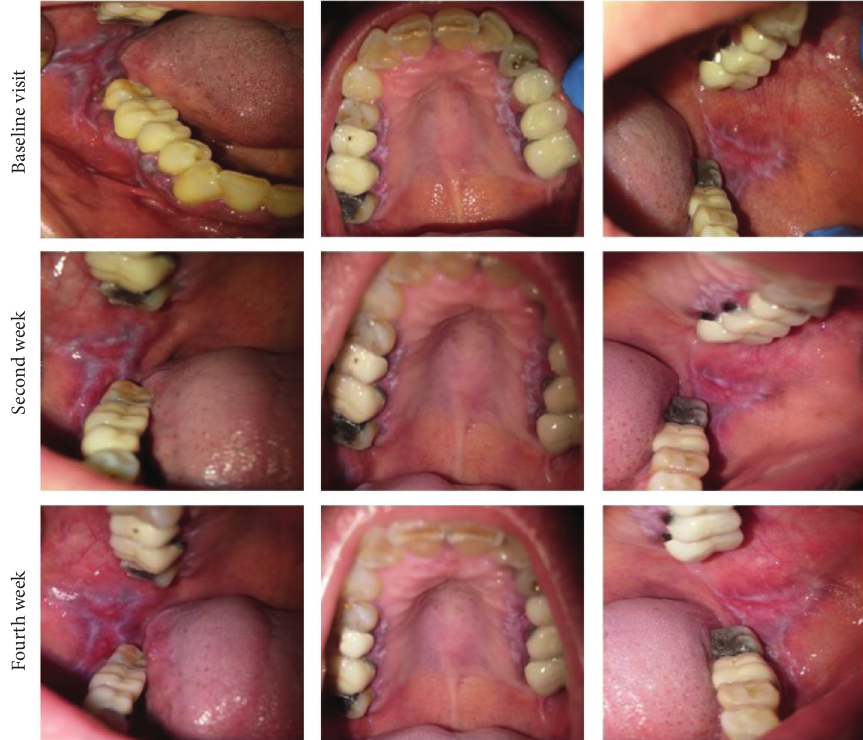
Figure 2: Intraoral photographs of a patient in the placebo group at baseline and at two and four weeks. Table 3: Comparison of the improvement level and the efficacy index at two and four weeks between the two groups. Two weeks Four